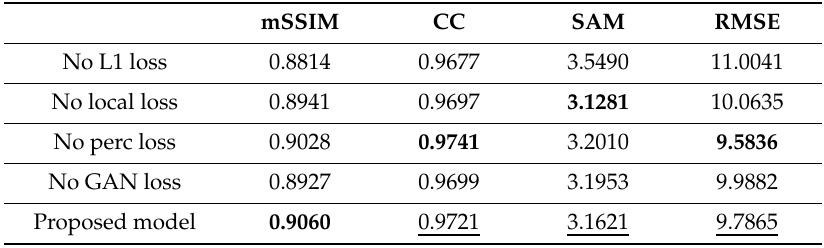
Table 4. Ablation Study in Terms of the Loss Functions.